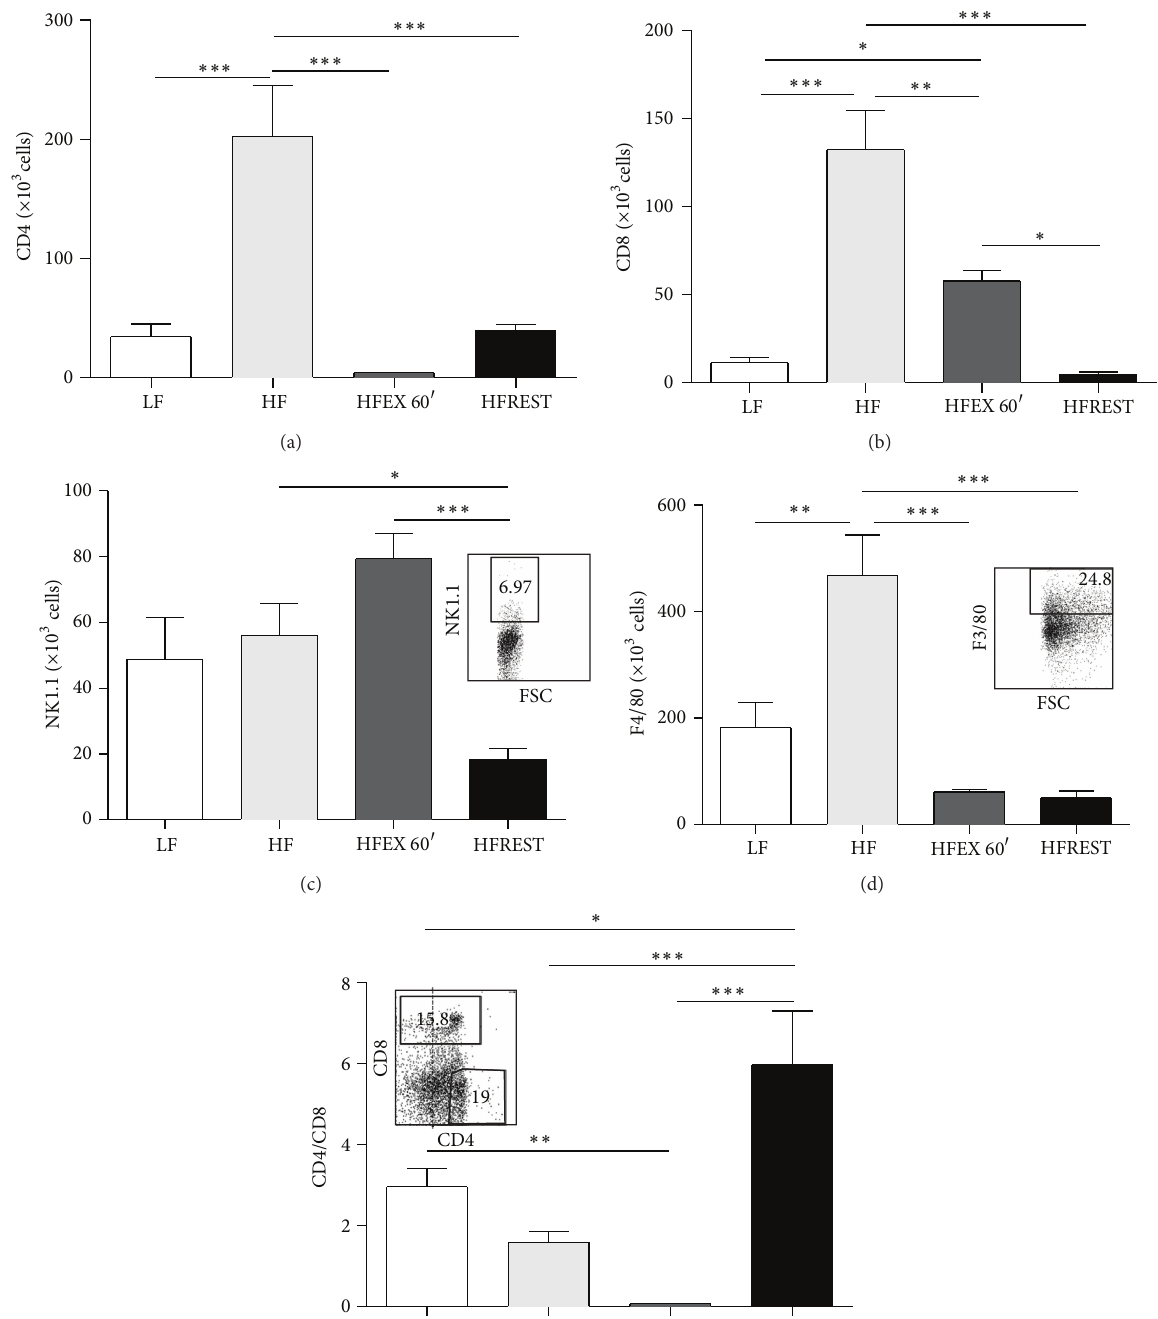
Figure 3: Quantification of cells expressing CD4, CD8, NK1.1, and F4/80 (macrophage) in inguinal adipose tissue of mice subjected to control diet (LF), high-fat diet (HF), high-fat diet with exercise (HFEX 60 󸀠 ), and high-fat diet with 30% food restriction (HFREST). (a) CD4 cells, (b) CD8 cells, (c) NK1.1 cells, (d) F4/80 cells, and (e) ratio of CD4/CD8. Mean ± SEM, 𝑛 = 5 mice per group. ∗∗∗ 𝑃 < 0.001 , ∗∗ 𝑃 < 0.01 , ∗ 𝑃 < 0.05